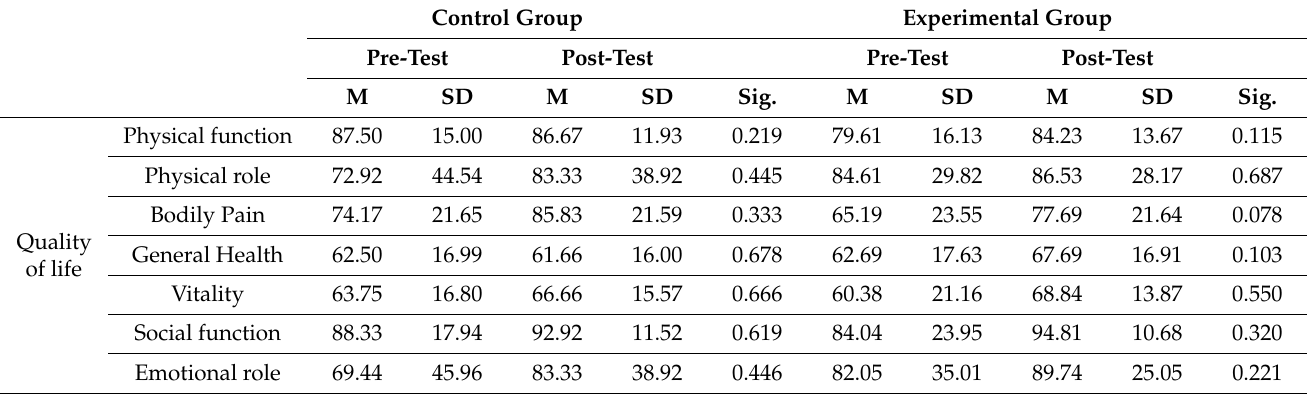
Table 1. Pre- and post-test results of the control and experimental